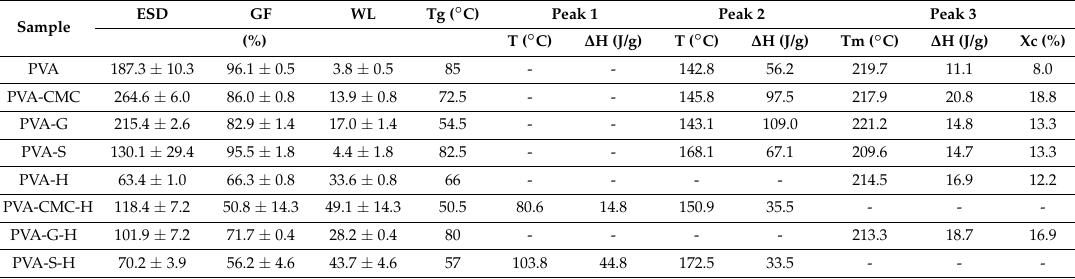
Table 6. DSC data of the evaluated